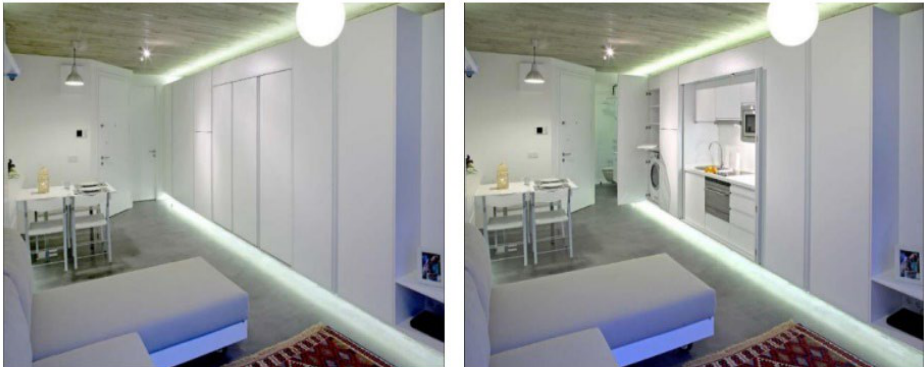
Figure 3 Plan of flat types in Le Corbusier’s residence project called Unité d’habitation in Marseilles (Le Corbusier World Heritage,